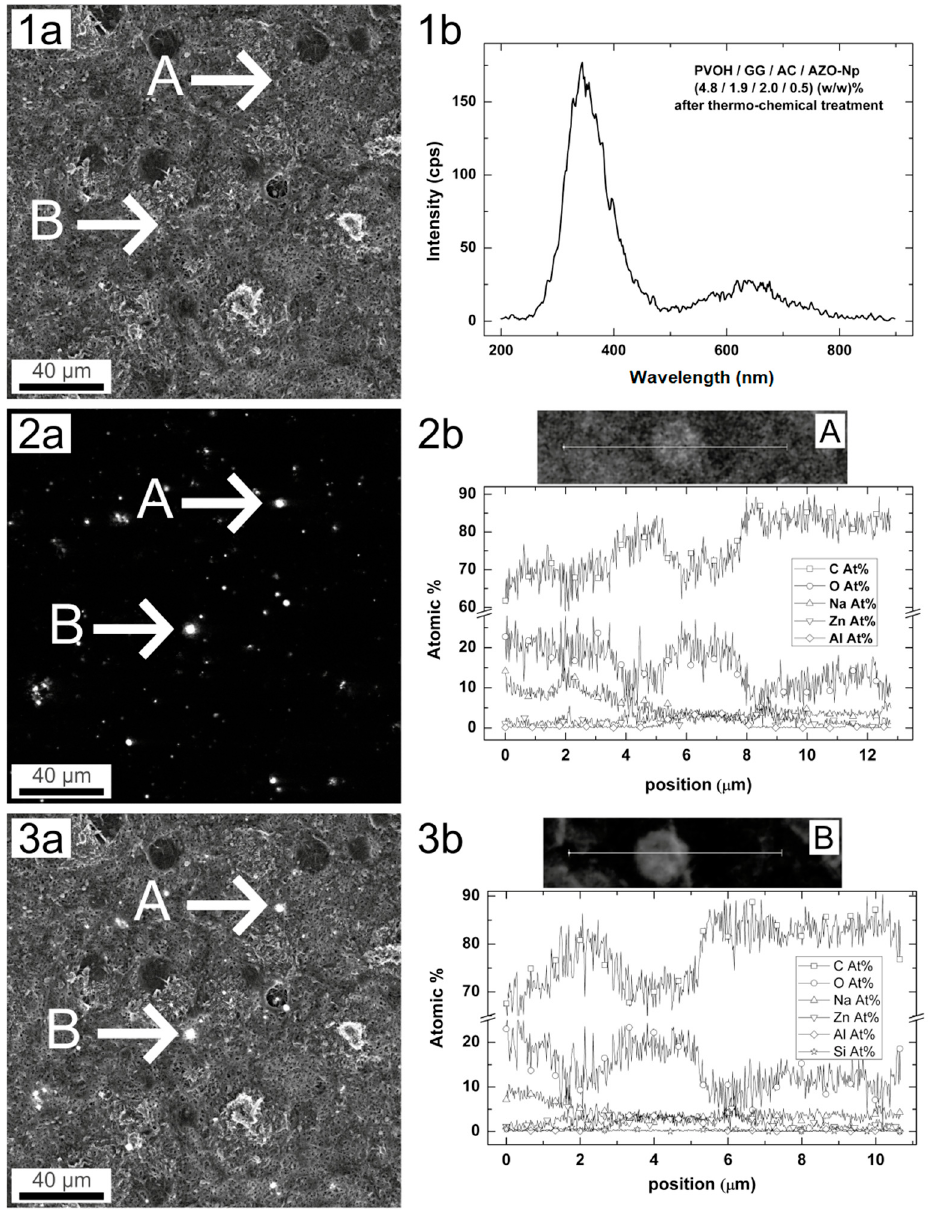
Figure 5. ( 1a ) SEM image sample (PVOH/GG/CA/AZO-Np) (4.8/1.9/2/0.5) ( w / w ) % after thermo- chemical treatment, 500 × . ( 2a ) CL image same sample showing two corresponding luminescence points, A, B, in ( a ). ( 3a ) CL image and SEM image together showing the point location. ( 1b ) Cl point spectrum (intensity × wavelength) on point A, sample (PVOH/GG/CA/AZO-Np) (4.8/1.9/2/0.5) ( w / w ) % after thermo-chemical treatment. ( 2b ) EDS elemental line profile analysis on reconstituted nanoparticles on point A. ( 3b ) EDS elemental line profile analysis on reconstituted nanoparticles on point